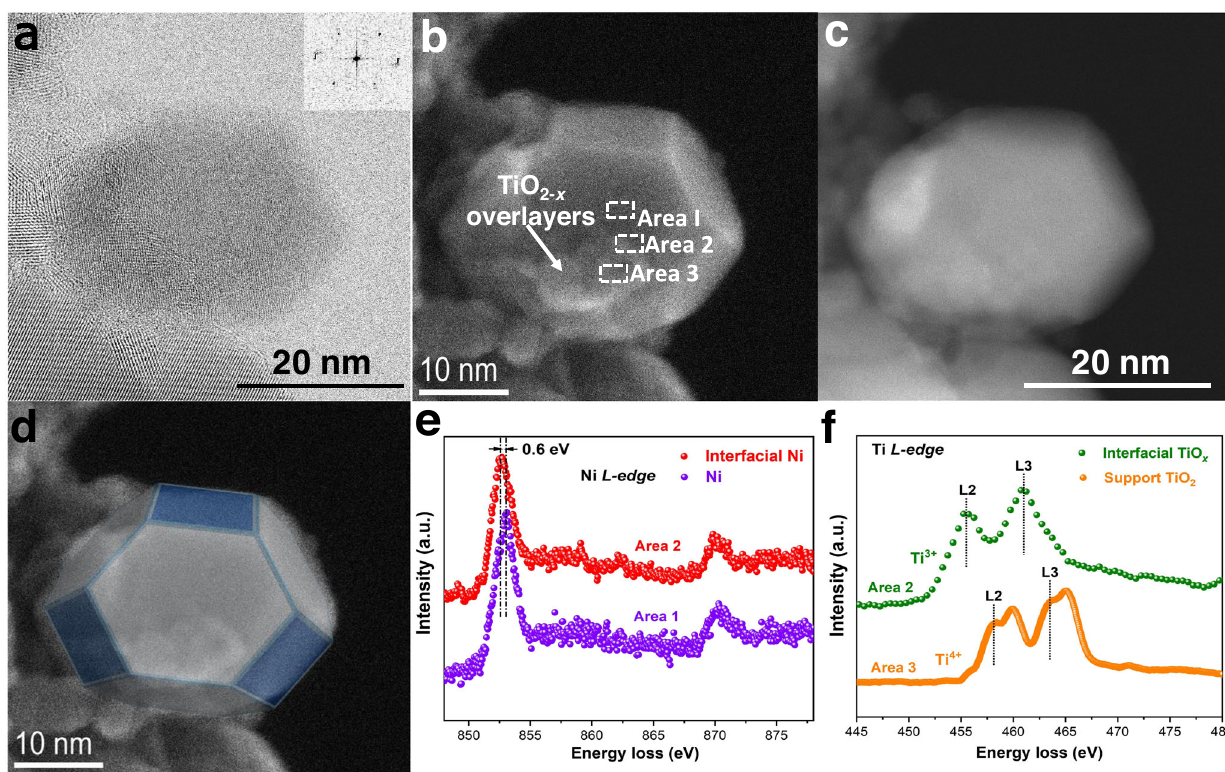
Fig.3|TherevelationofstructureandmorphologyforTiO 2 − x /Ni-450catalyst. a STEM-BF ( b ) STEM-SE and ( c ) STEM-ADF images of TiO 2 − x /Ni-450 catalyst after reductioninH 2 atmosphere(10Pa)at450°C. d SchematicdiagramofNiparticleas